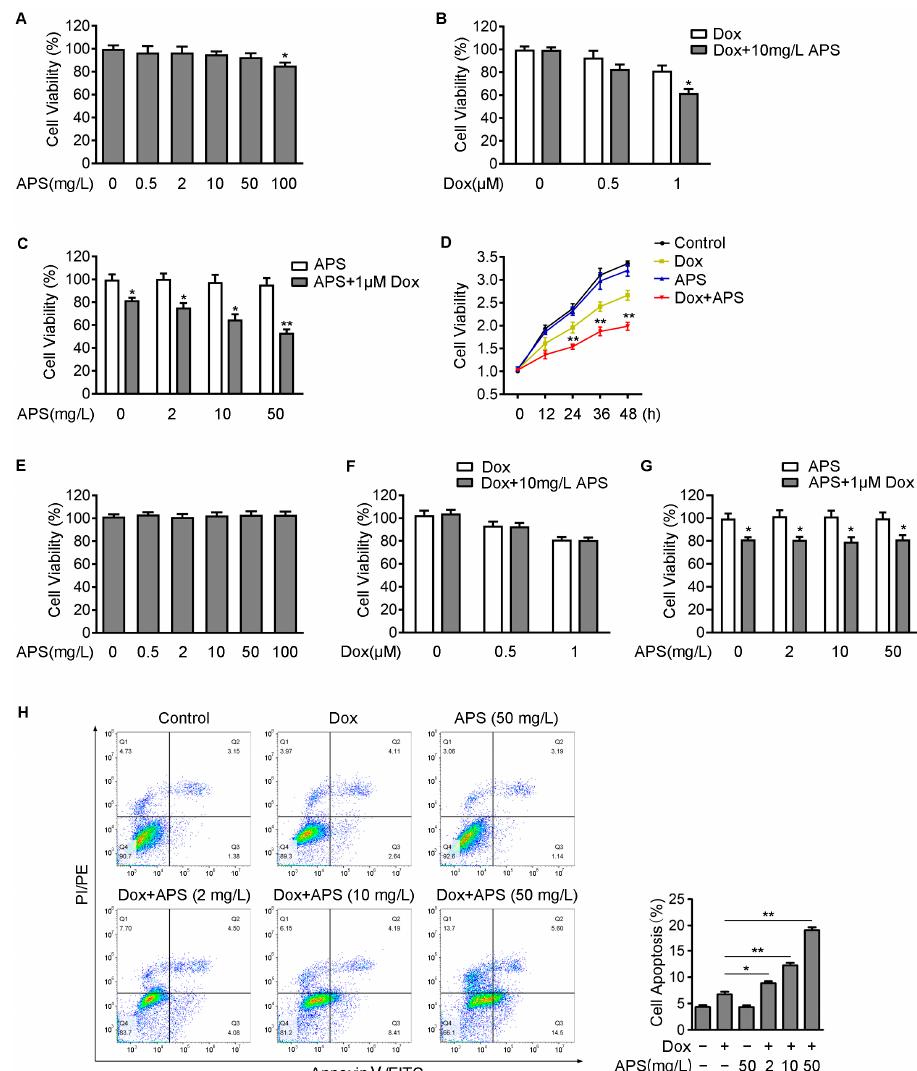
Figure 1. APS enhanced Dox-induced cell death in hepatocellular carcinoma Hep3B cells. Hep3B cells ( A ) or L02 cells ( E ) were treated with APS (0, 0.5, 2, 10, 50, 100 mg/L) and analyzed using a CCK-8 assay. In the presence or absence of 10 mg/L APS, Hep3B cells ( B ) or L02 cells ( F ) were treated with Dox (0, 0.5, 1 μ M) for 24 h, and subjected to CCK-8 detection. Hep3B cells ( C ) and L02 cells ( G ) were treated with APS (0, 2, 10, 50 mg/L) in the absence or presence of 1 μ M Dox for 24 h, and cell viability was determined using CCK-8 assay. ( D ) Hep3B cells were cultured with normal medium (control group), 1 μ M Dox, 50 mg/L APS and 1 μ M Dox + 50 mg/L APS for 48 h and assayed for cell viability every 12 h. ( H ) Hep3B cells were treated with 1 μ M Dox along with or without increasing doses of APS (2, 10, 50 mg/L), and a flow cytometry assay was used to detect the cell apoptosis. Data are expressed as mean ± SEM from three independent experiments. *, p < 0.05, **, p < 0.01.